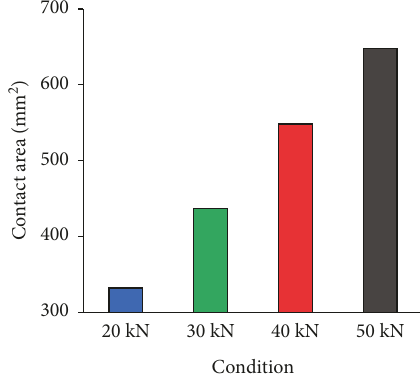
Figure 7: Contact area under different